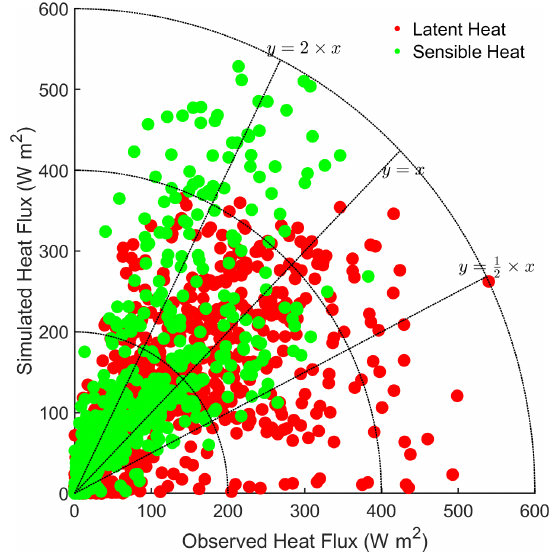
Figure 1. Comparison of observed and simulated fluxes of latent heat and sensible